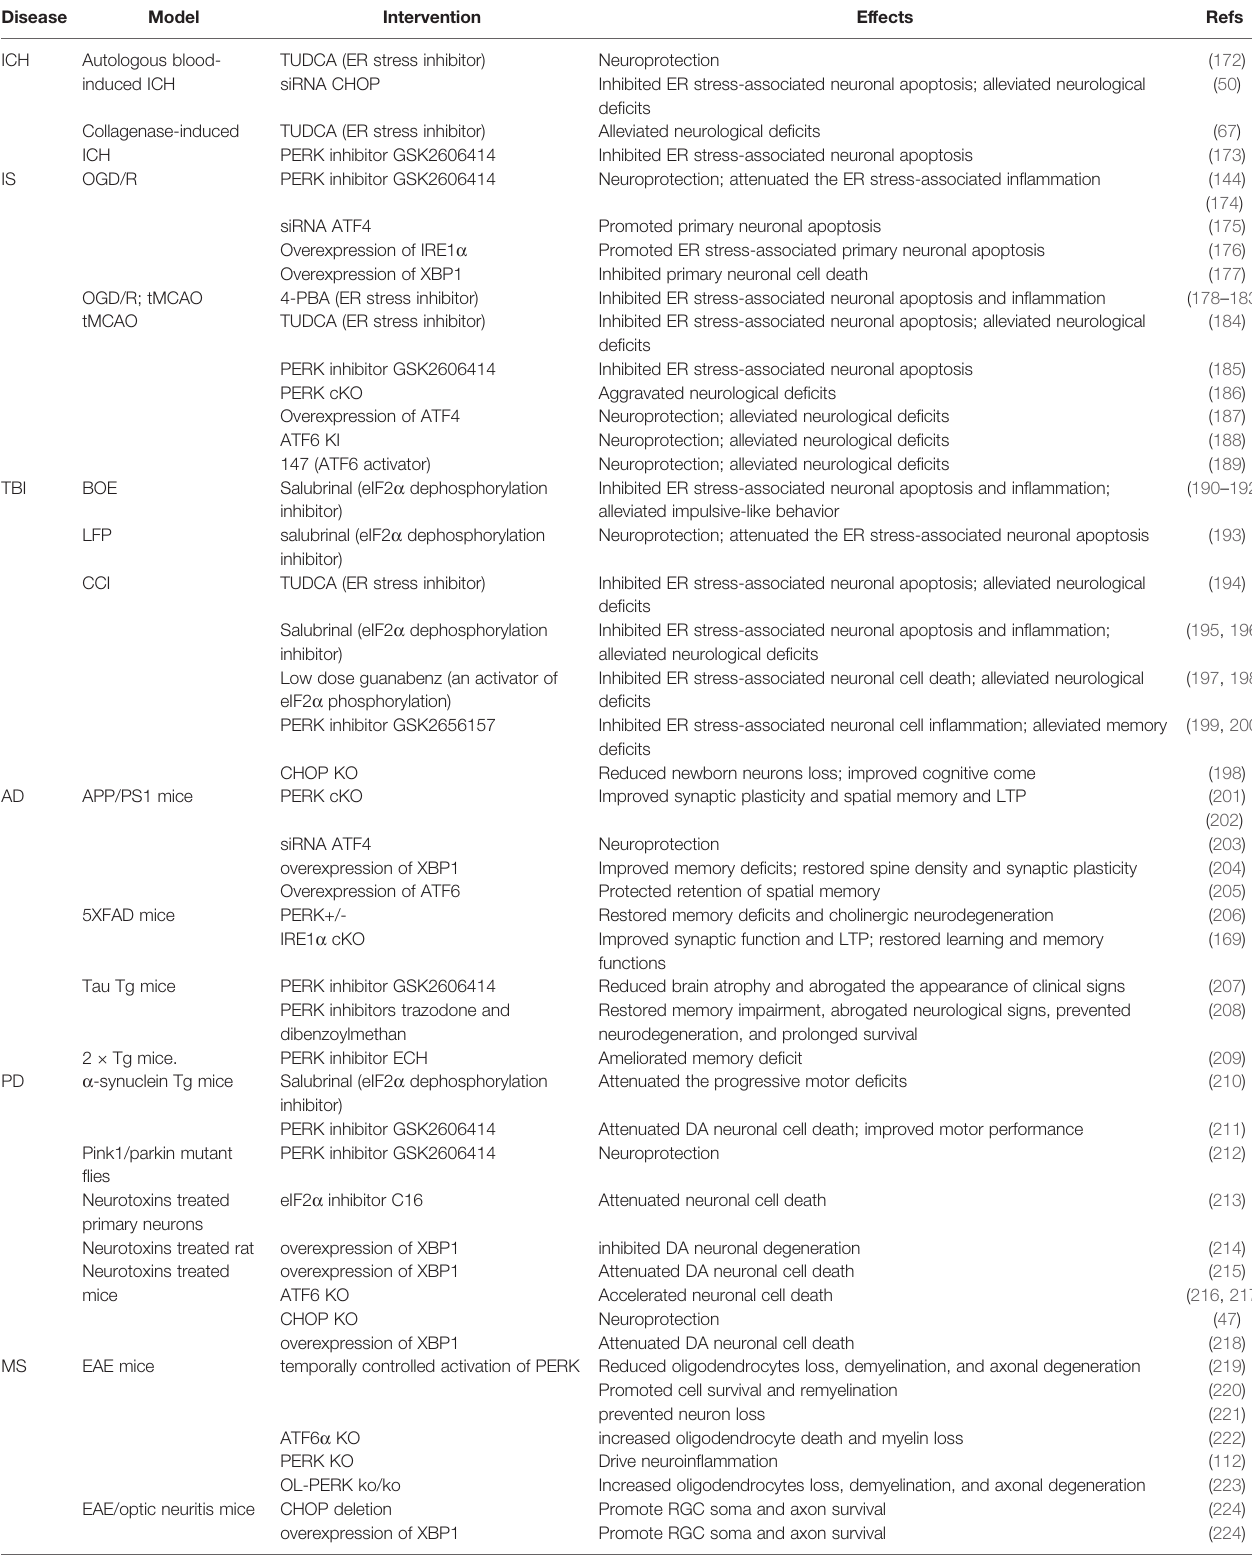
TABLE 1 | Functional impact of ER stress in neurological